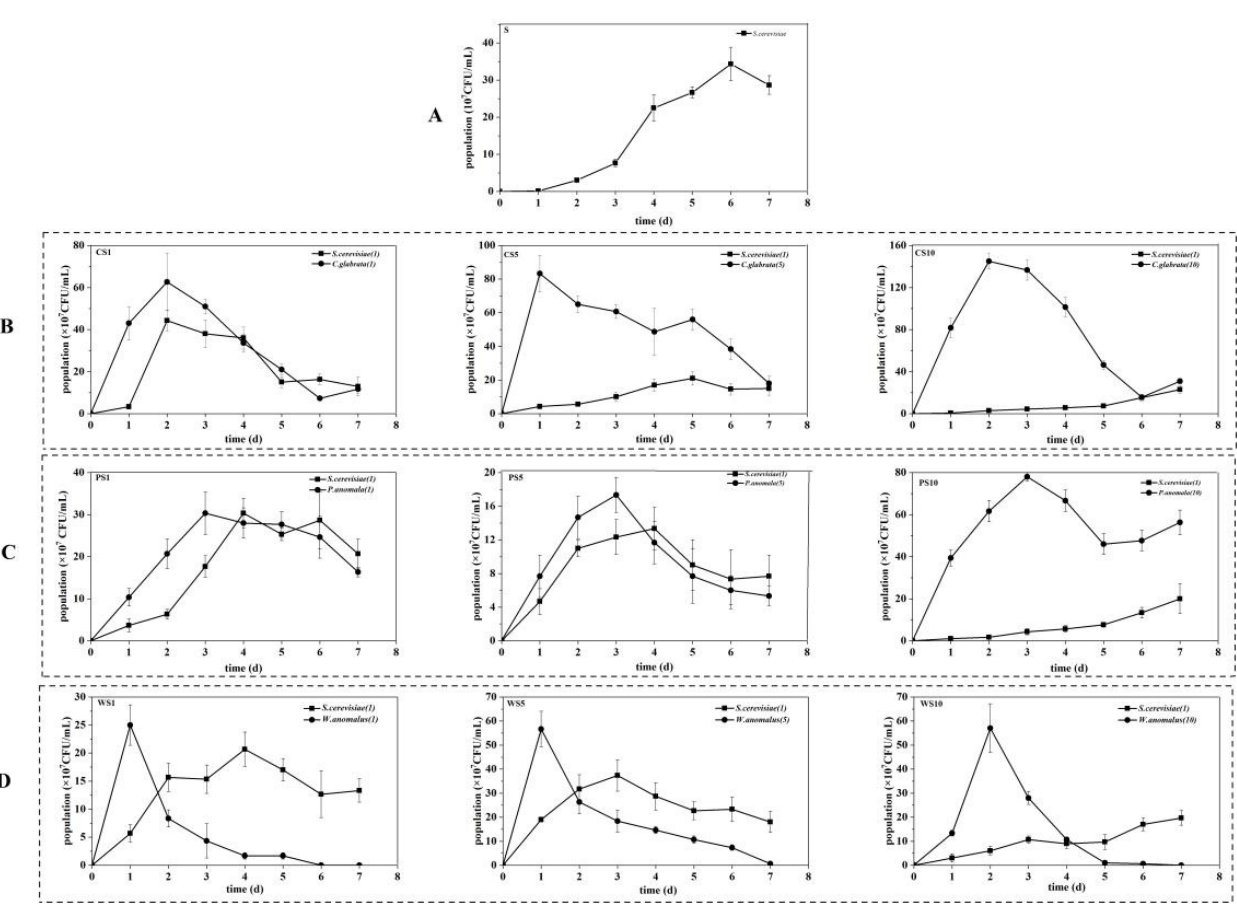
Figure 2. Growth of yeasts during the simulated fermentation of blueberry wine. ( A ) pure fer- mentation of S. cerevisiae NCUF309.2; ( B ) co-fermentation of C. glabrata NCUF308.1 and S. cerevisiae NCUF309.2; ( C ) co-fermentation of P. anomala NCUF306.1 and S. cerevisiae NCUF309.2; ( D )